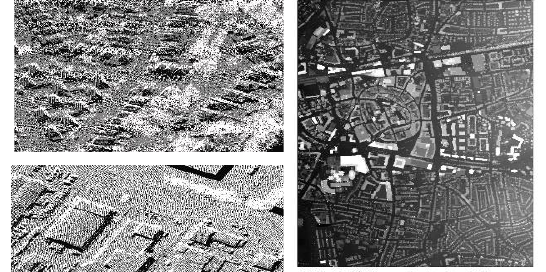
Figure 3. Sample data of LiDAR point clouds (left) and the derived DSM with 0.5 meters of spatial resolution (right)